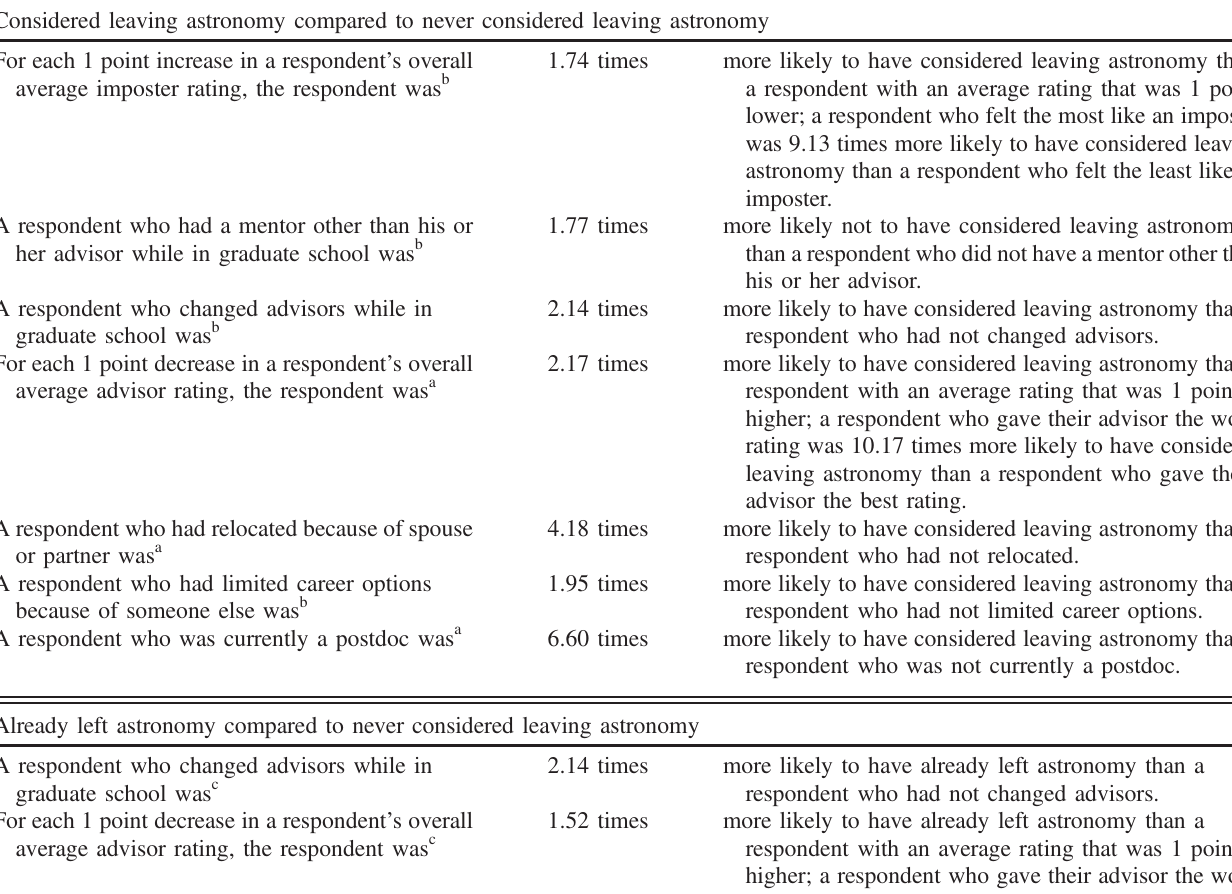
TABLE II. Factors directly affecting respondents ’ thoughts about or decision to leave astronomy. Considered leaving astronomy compared to never considered leaving astronomy For each 1 point increase in a respondent ’ s overall average imposter rating, the respondent was